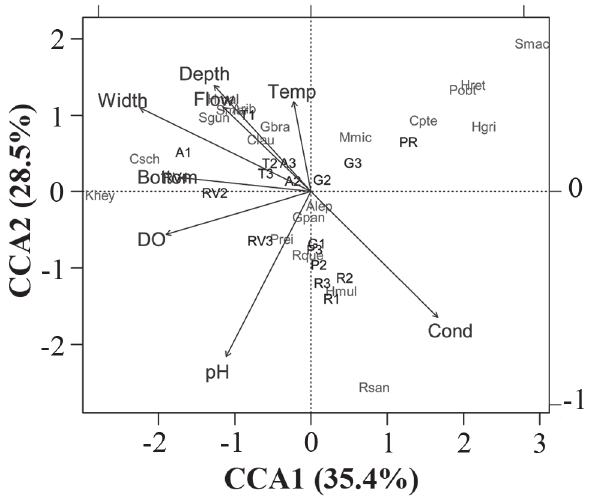
Fig. 4. Ordination resulted from canonical correspondence analysis according to ichthyofauna abundance in each site in relation to physical and structural characteristics of the habitat. Habitat variables: temperature (Temp), pH concentration (pH), dissolved oxygen (DO), conductivity (Cond), stream width (Width), stream flow (Flow), bottom type (Bottom), and stream depth (Depth). Streams: Antas (A), Tetequera (T), Grajaúna (G), “Ponte 2” (P), rio Verde (RV), “Riacho 1” (R), and rio Preto (PR). Stretches: upper (1), middle (2), and lower (3). Percentages of explanation of the axes are given in parentheses. The bottom and left-hand scales are for the sites and the fish species, the top and right-hand scales are for the habitat variables. The species acronyms are presented on Table